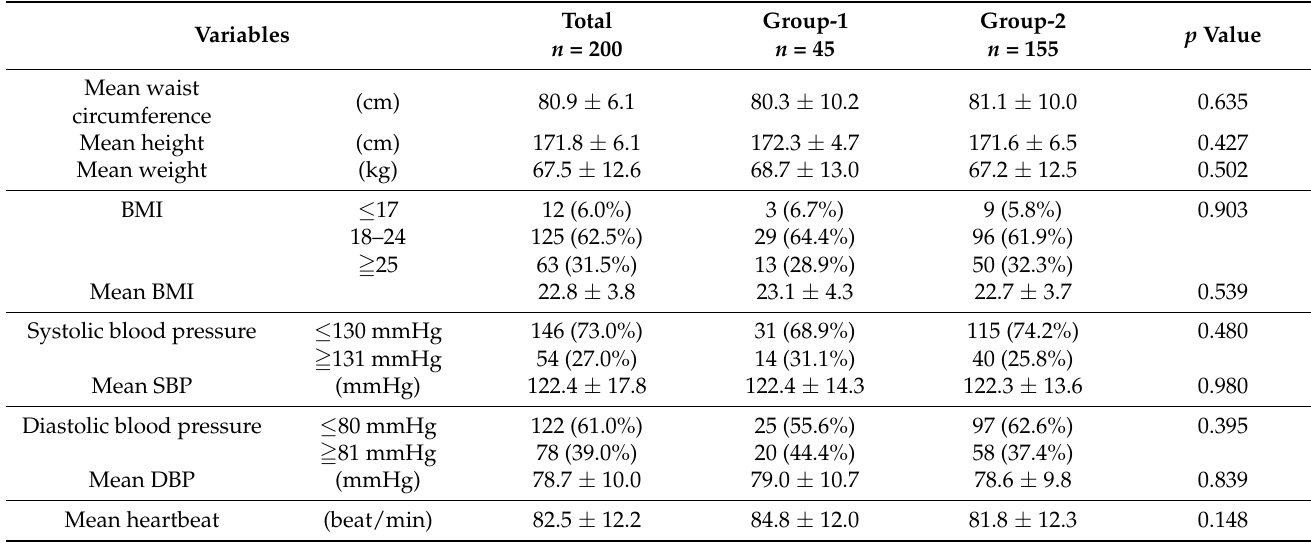
Table 2. Basic physiological data of the participants ( n = 200).